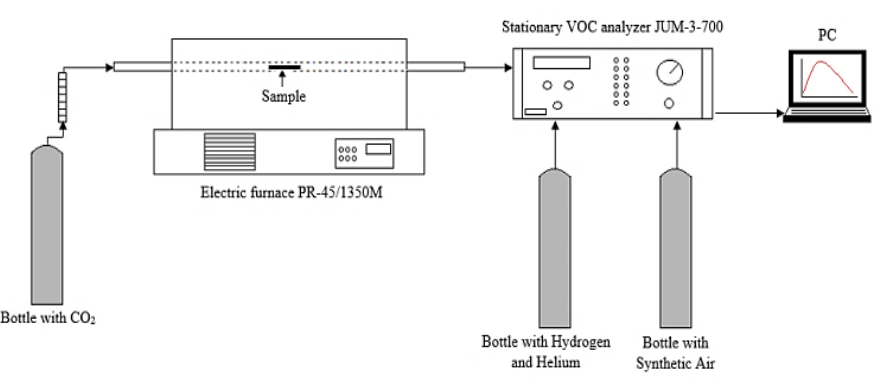
Figure 19. Installation for VOC analysis of “torgas” during the Miscanthus torrefaction process using an electric furnace.